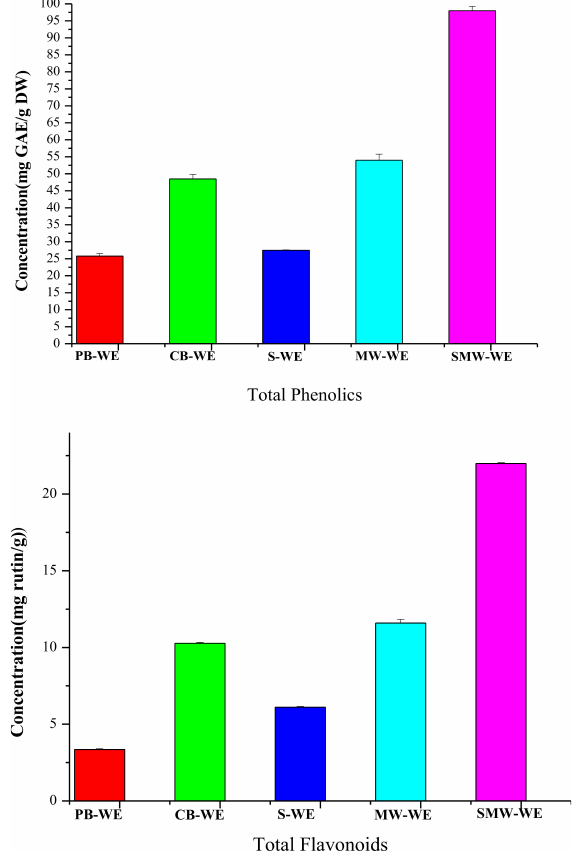
Figure 1. ( A ) Graph showing total phenolics extracted using the five extraction methods; ( B ) Graph showing flavonoid contents from Graviola leaf following extraction using the five different